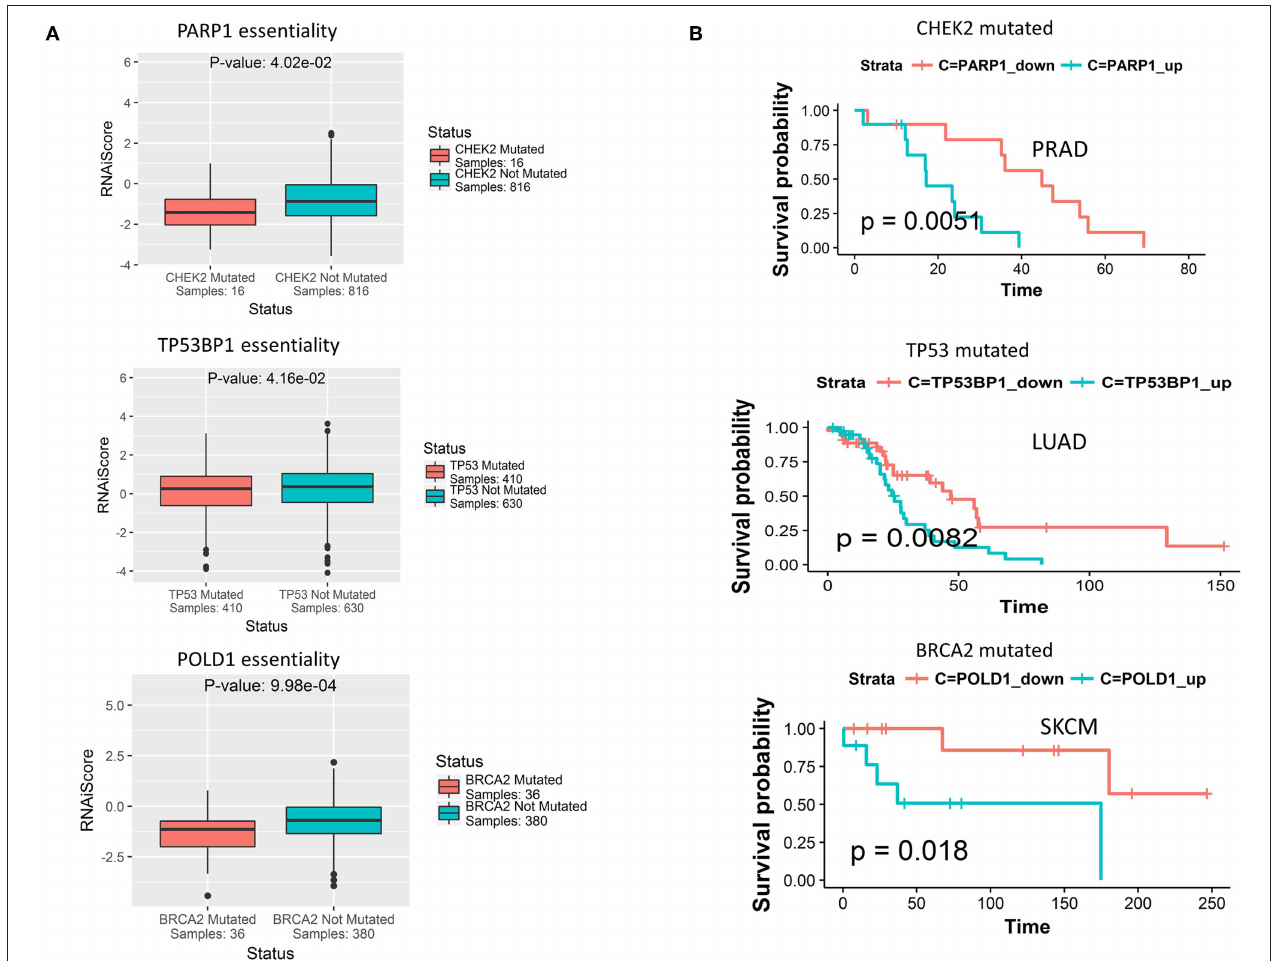
FIGURE 5 | (A) Predicted synthetic lethal partners for gene mutations specific to each DDR cluster, that have conditional essentiality in presence of the corresponding gene mutations as observed from cancer cell line RNAi screening data from Achilles portal. The term RNAiScore in y-axis is used to represent the essentiality score of genes in shRNA screenings processed by ATARiS algorithm, as collected from the Achilles project v 2.4.3 (described in the data collection section in Methods). The more negative RNAiScore, the more essential the corresponding gene. (B) From TCGA genomic and clinical data, certain predicted synthetic lethal genes of the primary genes from each of the three DDR cluster show survival advantage in terms of increased disease-free survival when down-regulated compared to when up-regulated (down < median, up > median) in certain cancer types in presence of somatic mutations in that DDR